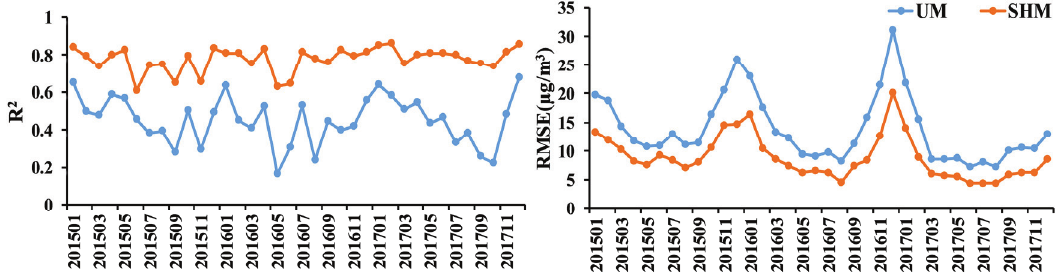
Figure 2. R 2 and root-mean-square error (RMSE) values of the derived uniform relationship model (UM) and spatiotemporal heterogeneous model (SHM) for MAPC over the study area during 2015– 2017.